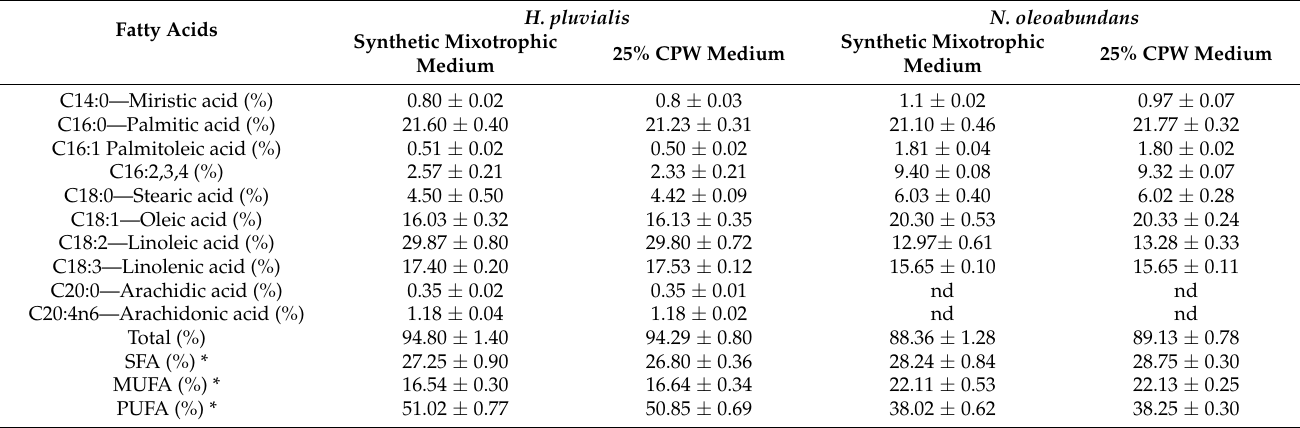
Table 7. Major fatty acid profile (percentage of total fatty acids) from microalgae culture after transesterification. Values are the mean of three replicates ( n = 3). SFA: Saturated fatty acids; MUFA: Monounsaturated fatty acids; PUFA: Polyunsaturated fatty acids; nd: Not